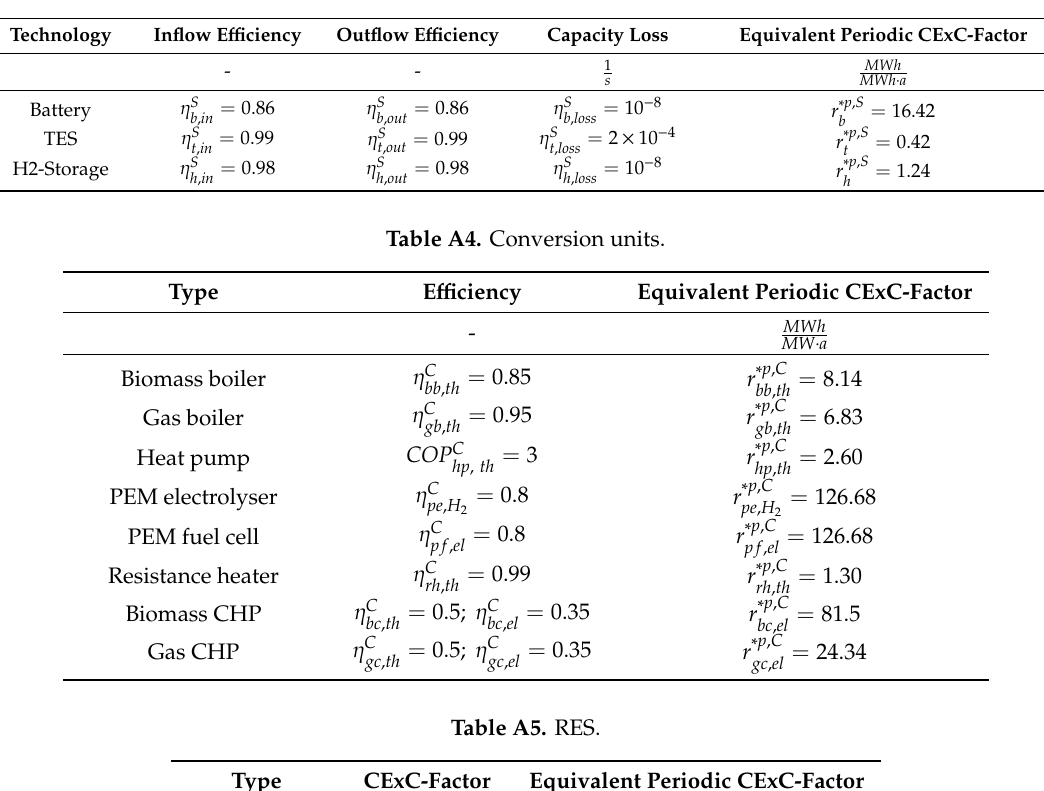
Table A3. Storages.